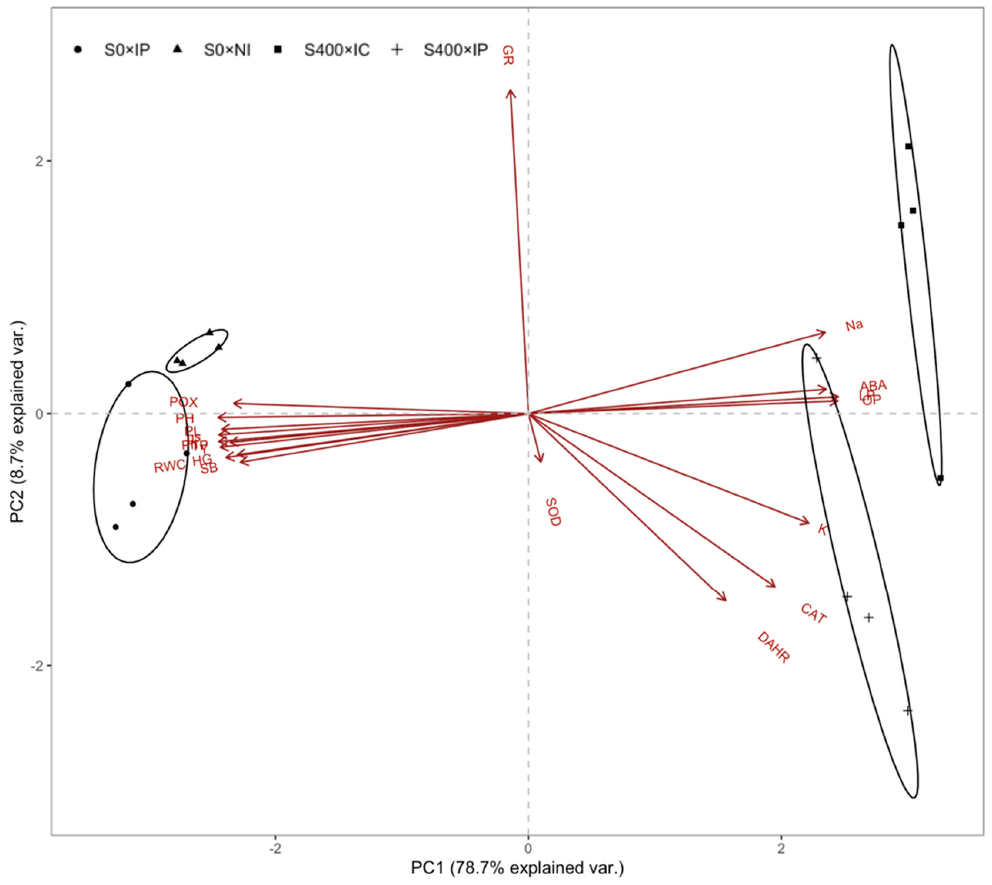
Figure 7. Biplot from PC 1 and PC 2 of principal components analysis (PCA) explained 83.60% of the total variability in data. The angle between two variables indicates correlation between them, acute and obtuse angles indicate positive and negative correlation respectively. For treatments: S0, non-saline (0 mM NaCl); S400, saline (400 mM NaCl); NI, un-inoculation; IP, PsJN inoculation. For variables, PH, plant height; SB, shoot biomass; PL, panicle length; HG, 100-grain yield; Y, grain yield; A n , photosynthetic rate; g s , stomatal conductance; LP, leaf potential; OP, osmotic potential; TP, turgor potential; Na, leaf Na + concentration; K, leaf K + concentration; ABA, leaf ABA concentration; SOD, superoxide dismutase; CAT, catalase; POX, peroxidase; GR, glutathione reductase; DHAR,